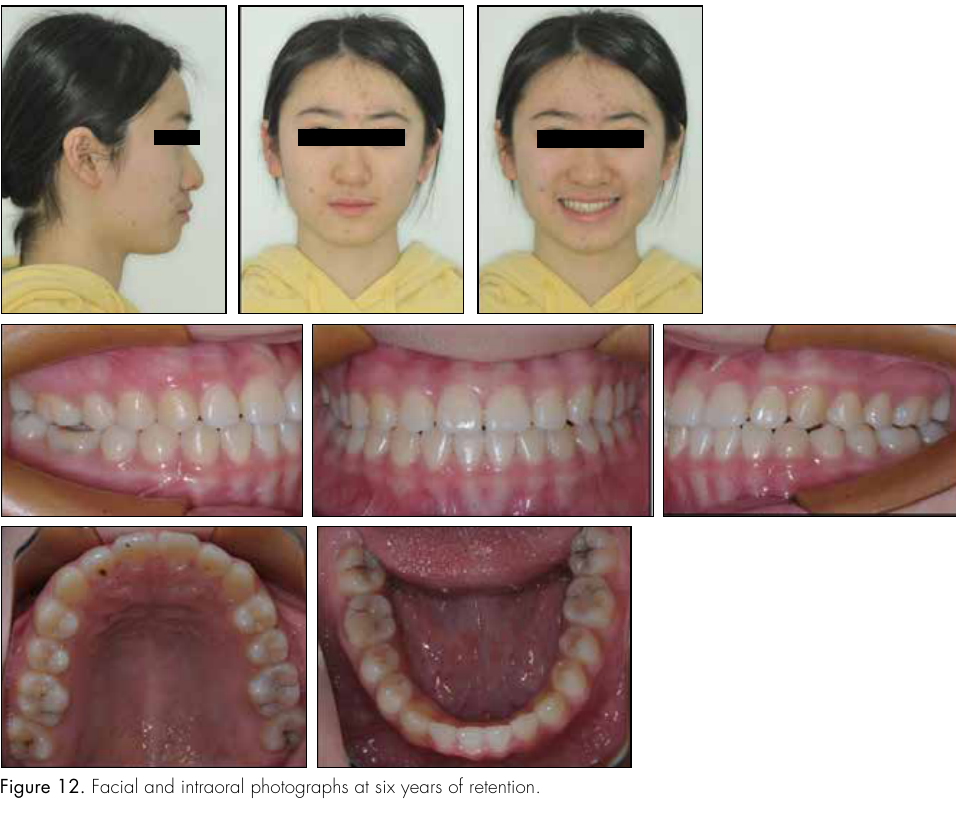
Figure 12. Facial and intraoral photographs at six years of retention.